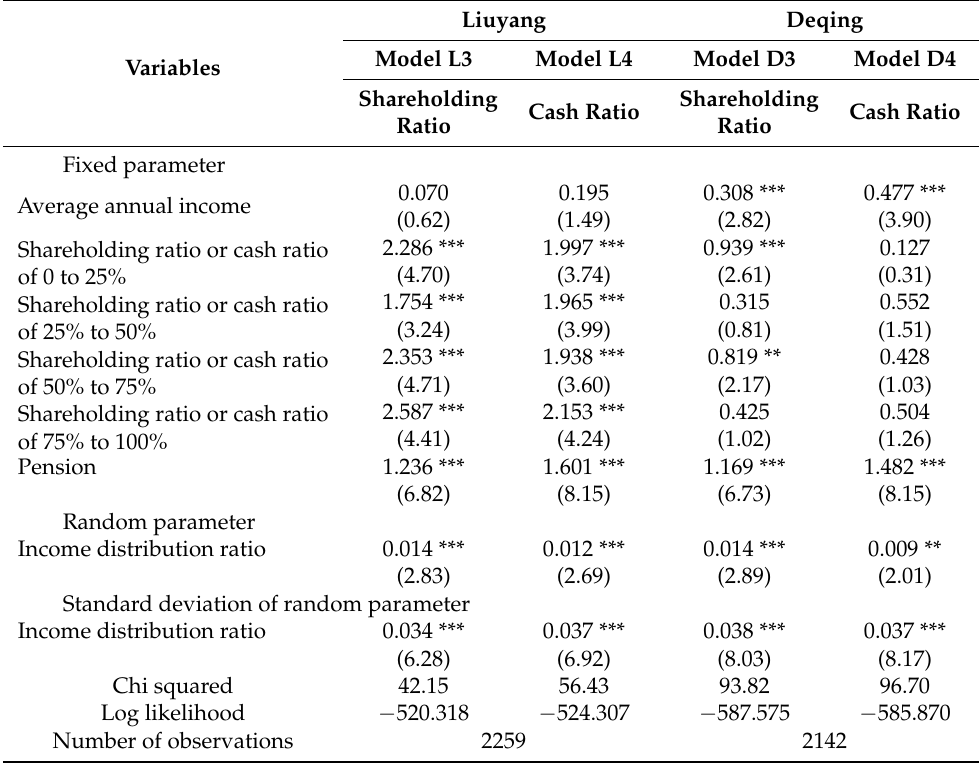
Table 8. Estimation results of random parameter Logit model based on group samples under shareholding ratio or cash